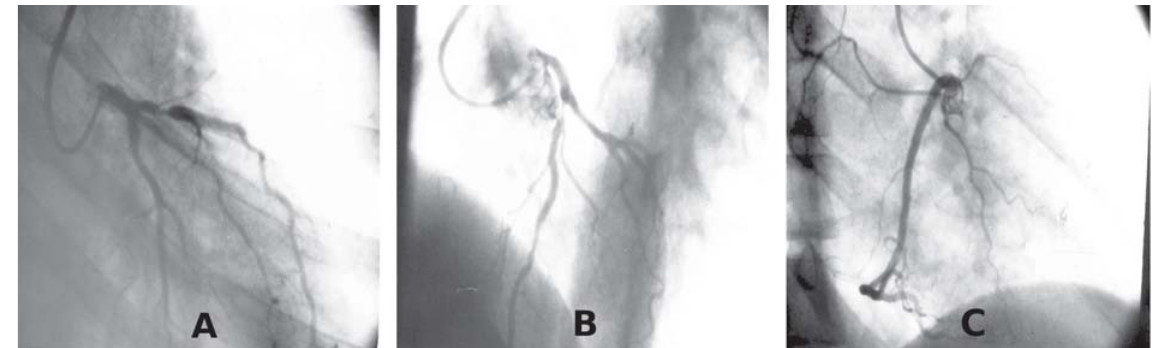
Fig. 1 - Angiografia coronária pré-operatória evidenciando a lesão grave em 1/3 proximal da AIA e CX, sem lesões obstrutivas em OAD (A) e OAE cranial (B). CD livre de lesões (C)